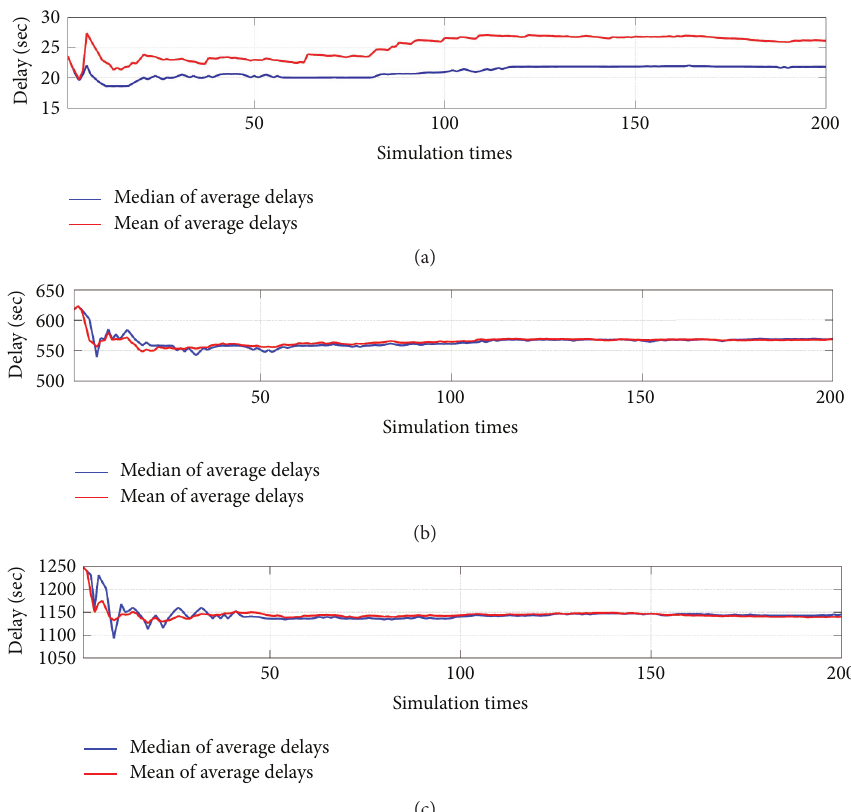
Figure 11: Median and mean of the average delays with different simulation times (a) when 1000 cars arrive, (b) when 2000 cars arrive, and (c) when 3000 cars